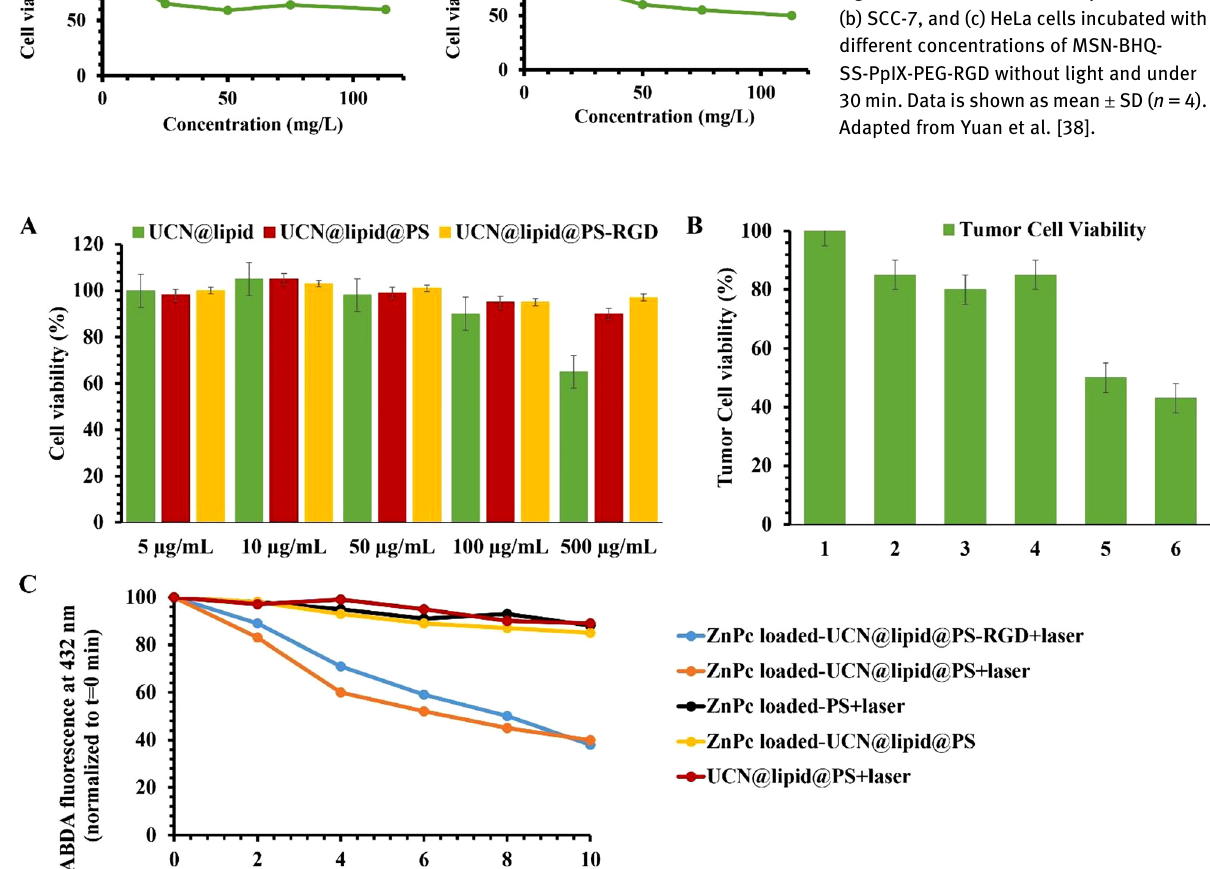
Figure 11: In vitro cell viability of (a) COS7, (b) SCC-7, and (c) HeLa cells incubated with different concentrations of MSN-BHQ- SS-PpIX-PEG-RGD without light and under 30 min.Data is shownas mean ± SD ( n =4). Adapted from Yuan et al. [38].